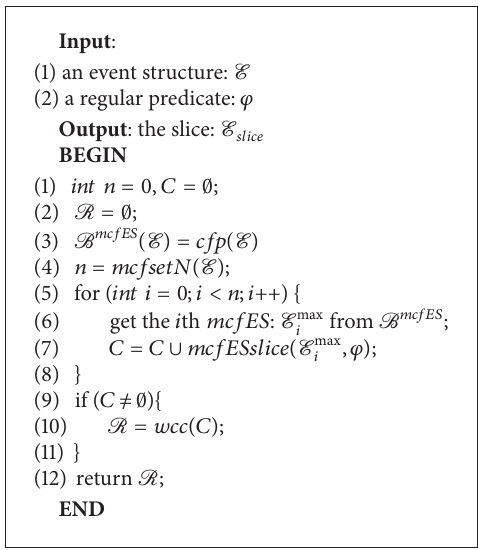
Algorithm 3: Slicing algorithm: 𝑠𝑙𝑖𝑐𝑒𝐸𝑆( E ,𝜑) .